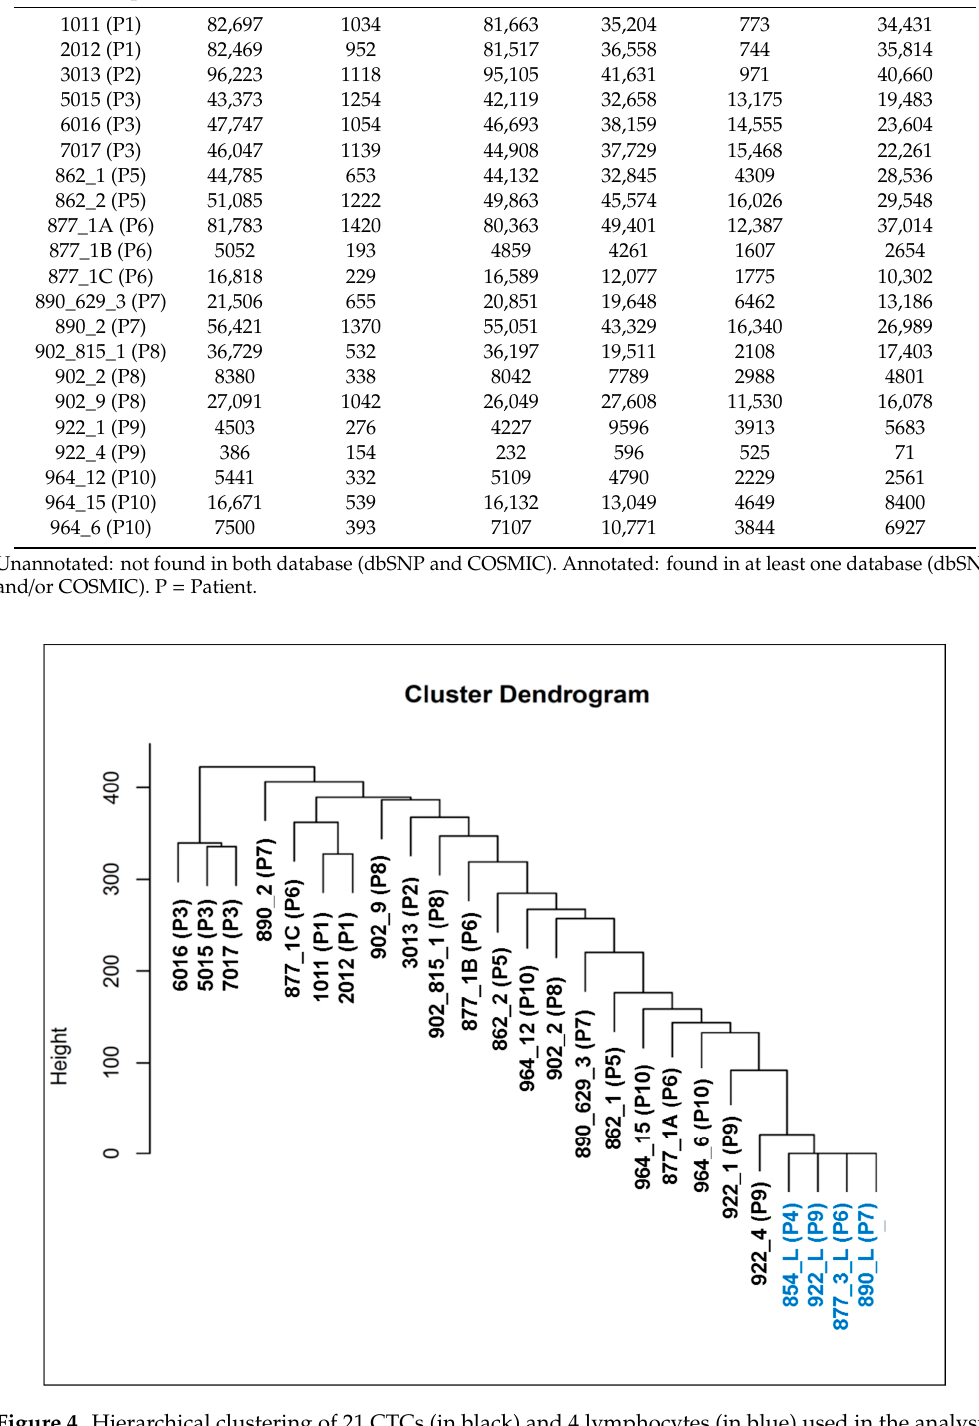
Figure 4. Hierarchical clustering of 21 CTCs (in black) and 4 lymphocytes (in blue) used in the analysis. The SNVs and indels are clustered using the average method, which performs a hierarchical cluster analysis using a set of dissimilarities between the samples. The y-axis (the heigh) are values of the distance in which two groups can split or merge, using the calculation of the Euclidean distance. P =